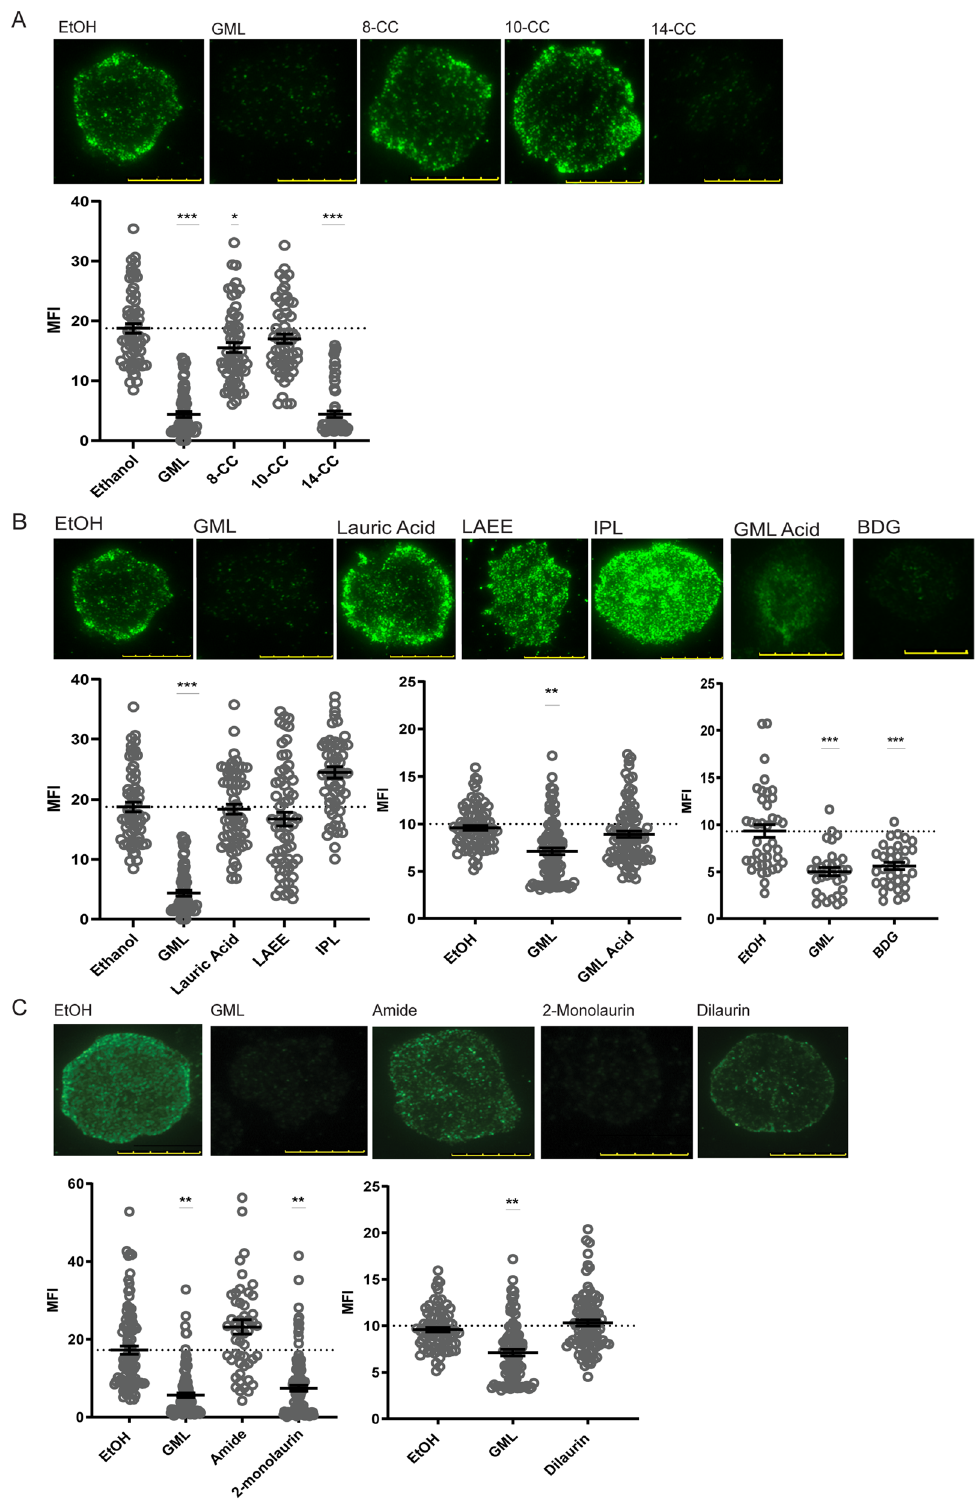
Figure 4. Chain length, head group polarity, and position impact the ability of GML to inhibit LAT clustering. APBTs were treated with 10ug/mL of designated compound and stimulated for 10 min using glass chamber slides coated with 10 ug/ml of anti-CD3. Cells were then fixed, permeabilized, and stained with antibodies specific for phosphorylated-LAT Y226. pLAT clustering in individual cells were imaged using TIRF. Representative individual cells are shown. Mean pixel intensities (MFI) of cells were quantified using ImageJ. Data compiled from at least 60 cells from 2 to 3 independent experiments are shown. The dotted line in each graph indicates MFI of EtOH, and data is plotted as mean with SEM. ( A ) Chain length ( B ) head polarity ( C ) linkage and Position (* p < 0.05, ** p < 0.01, *** p < 0.001, scale bar = 10